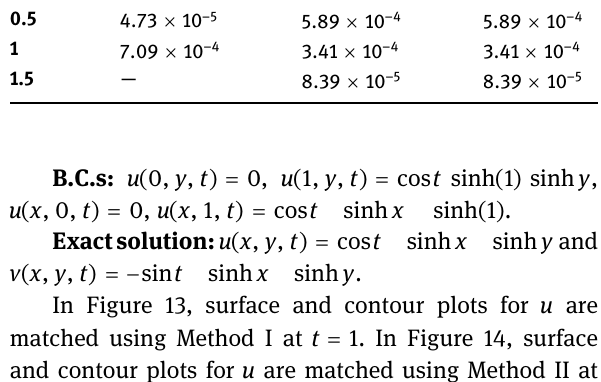
In Figure 15, surface and contour plots for u are pro - vided at t = 1 using Method I. In Figure 16, surface and contour plots are given at t = 1 using Method II. In Table are compared with [ 8 ] using Methods I 23, L u 2 and L u ∞ and II. The present results are highly acceptable.